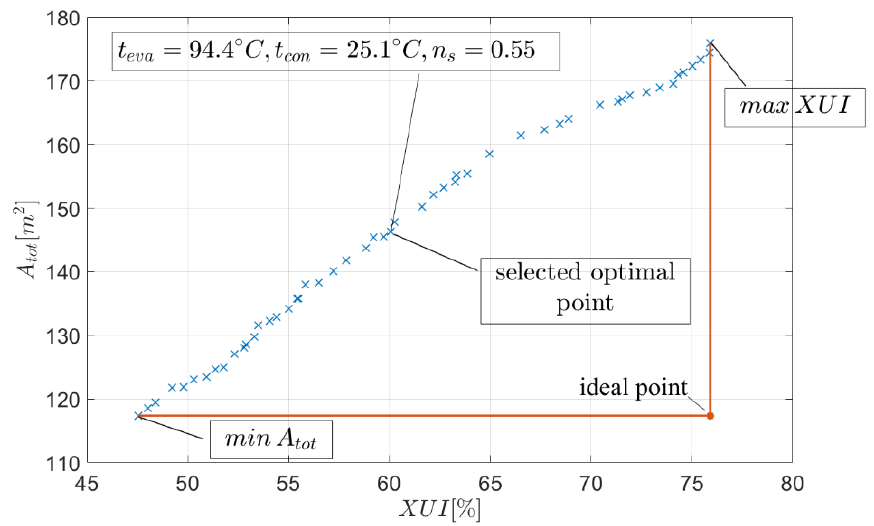
Figure 11. Pareto Figure 11. Pareto frontier. Table 4. Results of the multi-objective optimization.